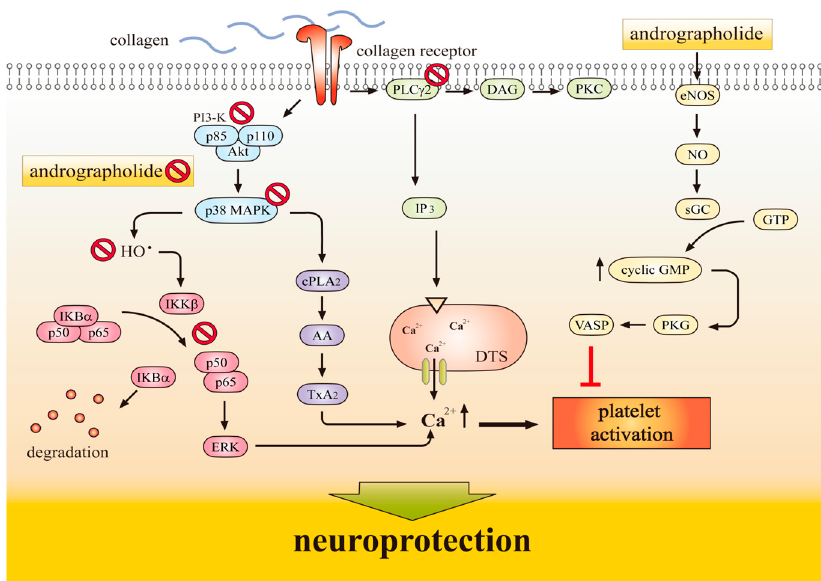
Figure 3 . Andrographolide’s antiplatelet effects conferring neuroprotection. Collagen binds to its Figure 3. Andrographolide’s antiplatelet effects conferring neuroprotection. Collagen